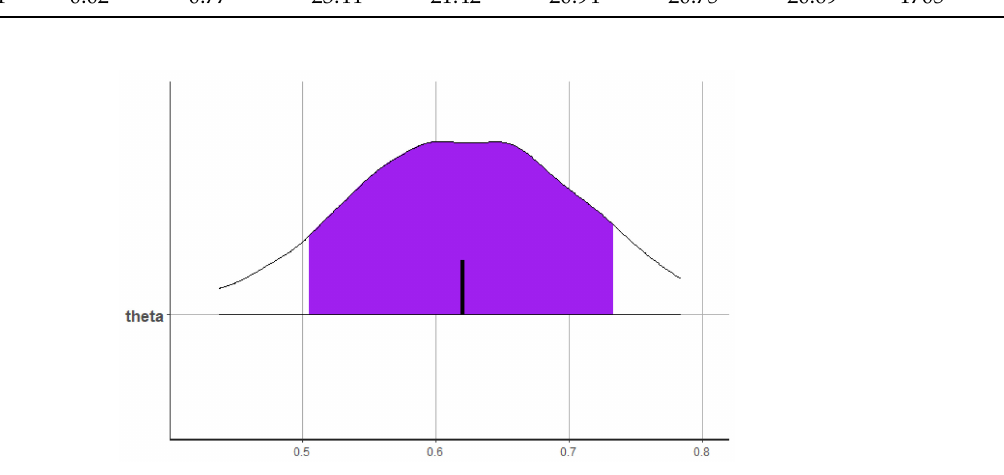
Figure 15. Posterior distribution of θ , as generated using RStan [51]. The purple shaded area implies the 80% credibility